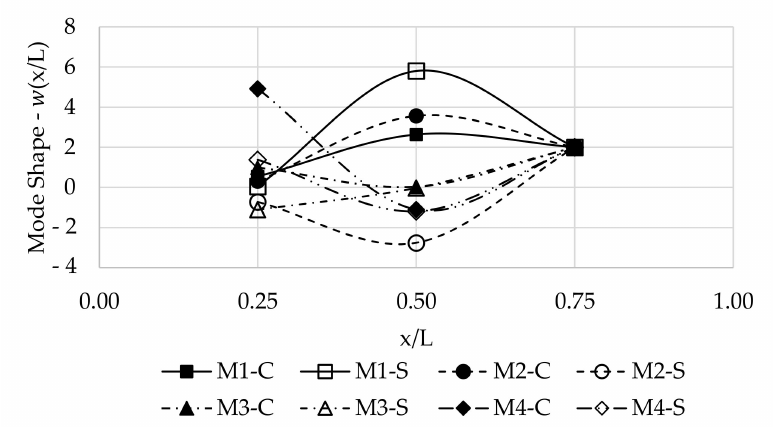
Figure 16. Modal identification: First four mode shapes with impact excitation. The prefix “M i ” indicates the mode number, the suffix “-C” and “-S” indicates the material, composite (GFRP) and steel, respectively.